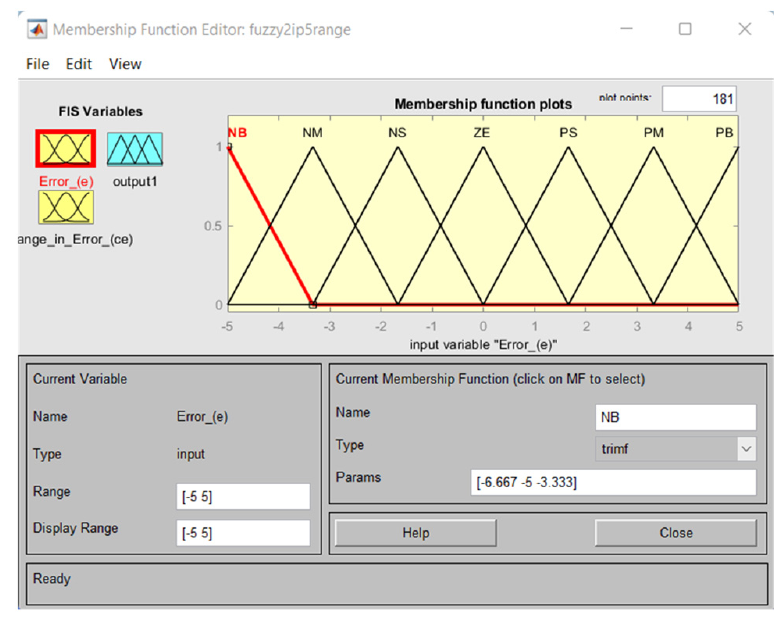
Figure 13. Designed fuzzy controller membership function. From the complete input and output values, the seven membership functions were examined, and a total of 49 rules were created particularly for the fuzzy controller. Figure 14 depicts the developed fuzzy controller rules, whereas Figure 15 depicts the appropriate surface plot of the fuzzy